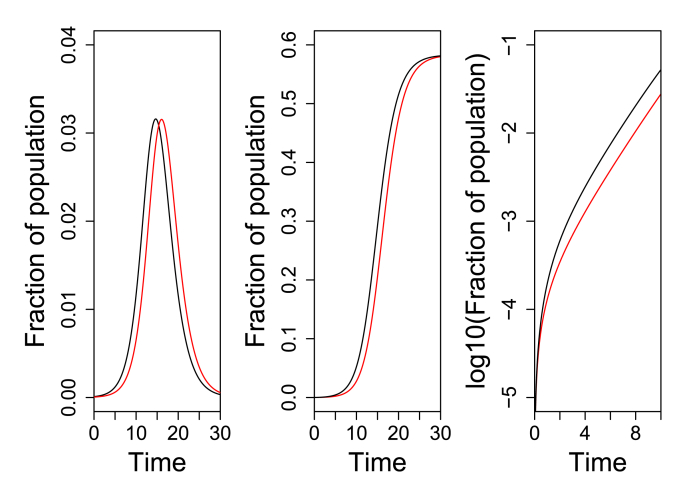
Comparing the different definitions of adherence. The left panel shows the people in I state from SIR model (red) and from IA state plus the IB state in SIAIBR model (black), with the same overall mean level of adherence. The resulting recovered curves are in the middle panel, with the right panel showing the recovered cases on log scale.